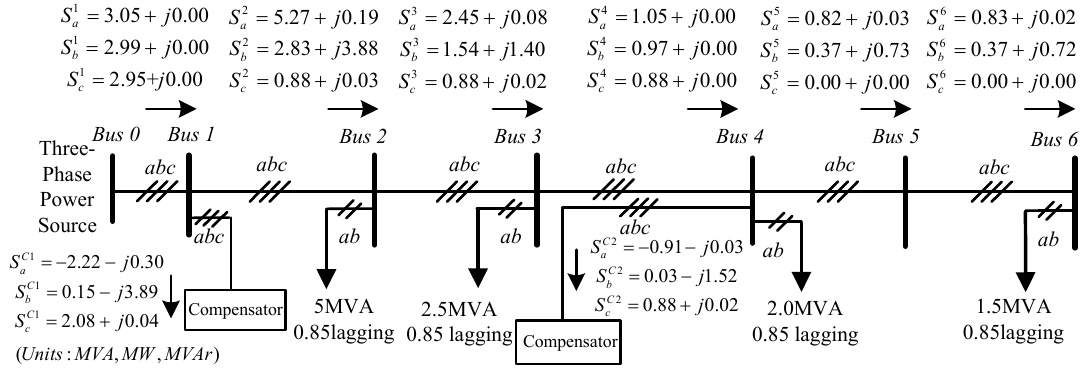
Figure 10. Power flow of Case 3. Table 4. Test result of Case 3.